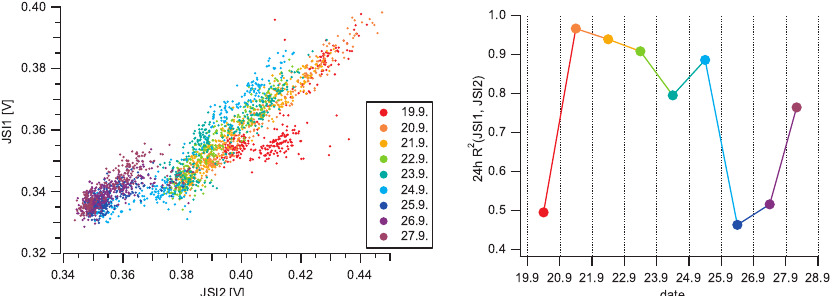
Figure 10. ( Left ) correlation between two identical devices using Sharp GP2Y sensors acquiring data simultaneously on the same spot during the environmental measurements (Figure 9). Each point corresponds to a five-minute average of the sensor’s output. While the correlation is clear ( R 2 = 0.77), both sensors do not have the same calibration and a time drift can clearly be observed. ( Right ) the coefficient of determination R 2 in 24-h intervals on different